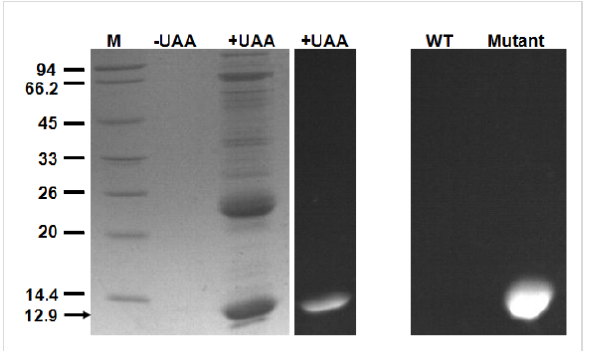
Figure 2: Coomassie-stained SDS-PAGE (left) of TAG38 mutant thioredoxin (indicated by the black arrow) expression in the presence and absence of 1 mM 1a . The right panel shows the fluorescence image of wild-type and TAG38 mutant thioredoxin.